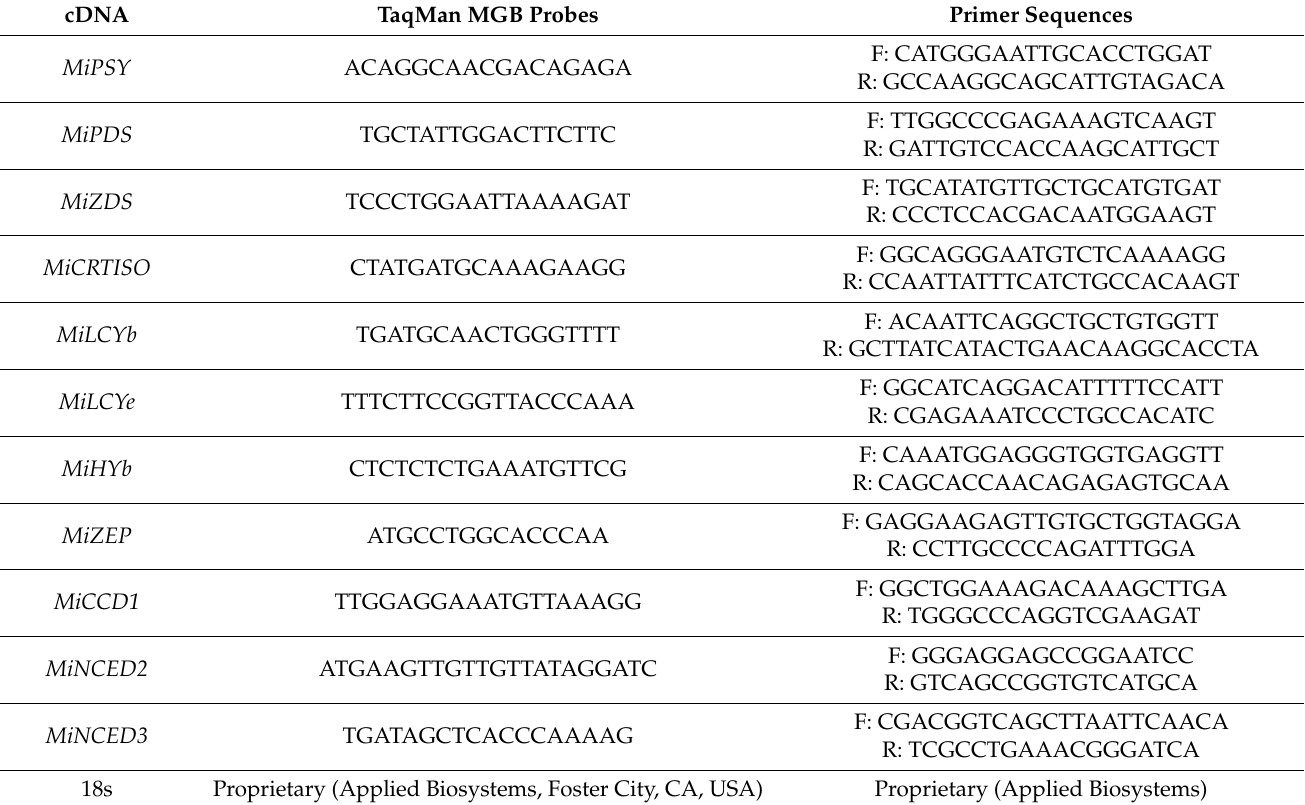
Table 2. TaqMan MGB probes and primers used for qRT-PCR of genes involved in carotenoid metabolism pathway. cDNA TaqMan MGB Probes Primer Sequences